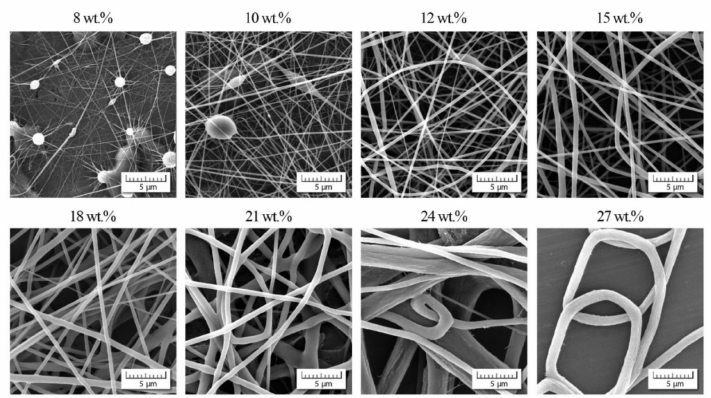
Figure 7. Scanning electron micrographs (SEM) showing the morphology of individual nanofibers for various copolymer concentrations and DMF/acetone ratio 1/1.